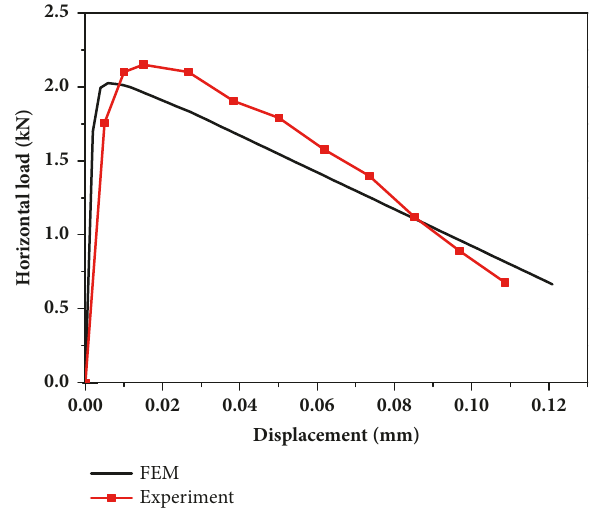
Figure 4: Comparison of load-displacement relationships between FEM and experimental results.